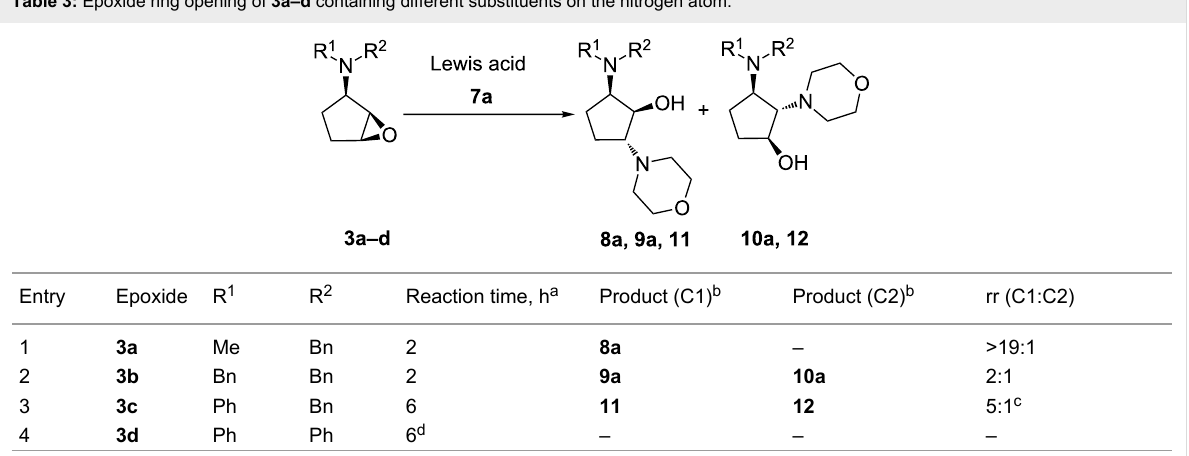
Table 3: Epoxide ring opening of 3a–d containing different substituents on the nitrogen atom.